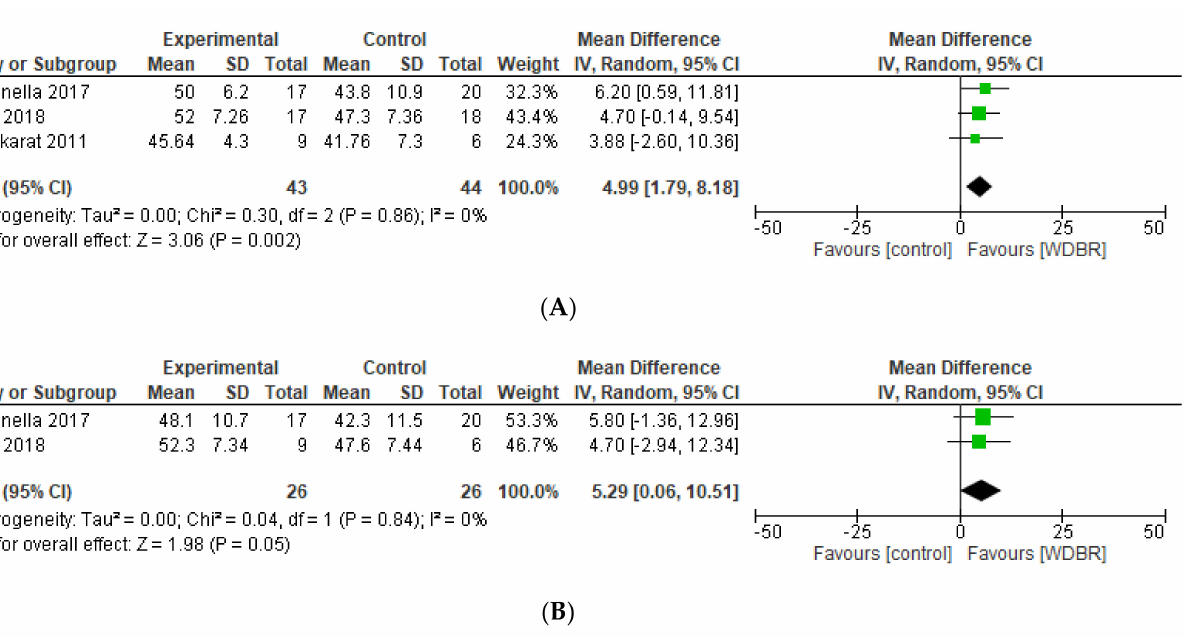
Figure 4. Forest plots of studies comparing add-on WDBR versus control. ( A ) Overall effect of WDBR versus control at postassessment on BBS. ( B ) Overall effect of WDBR versus control at follow-up assessment on